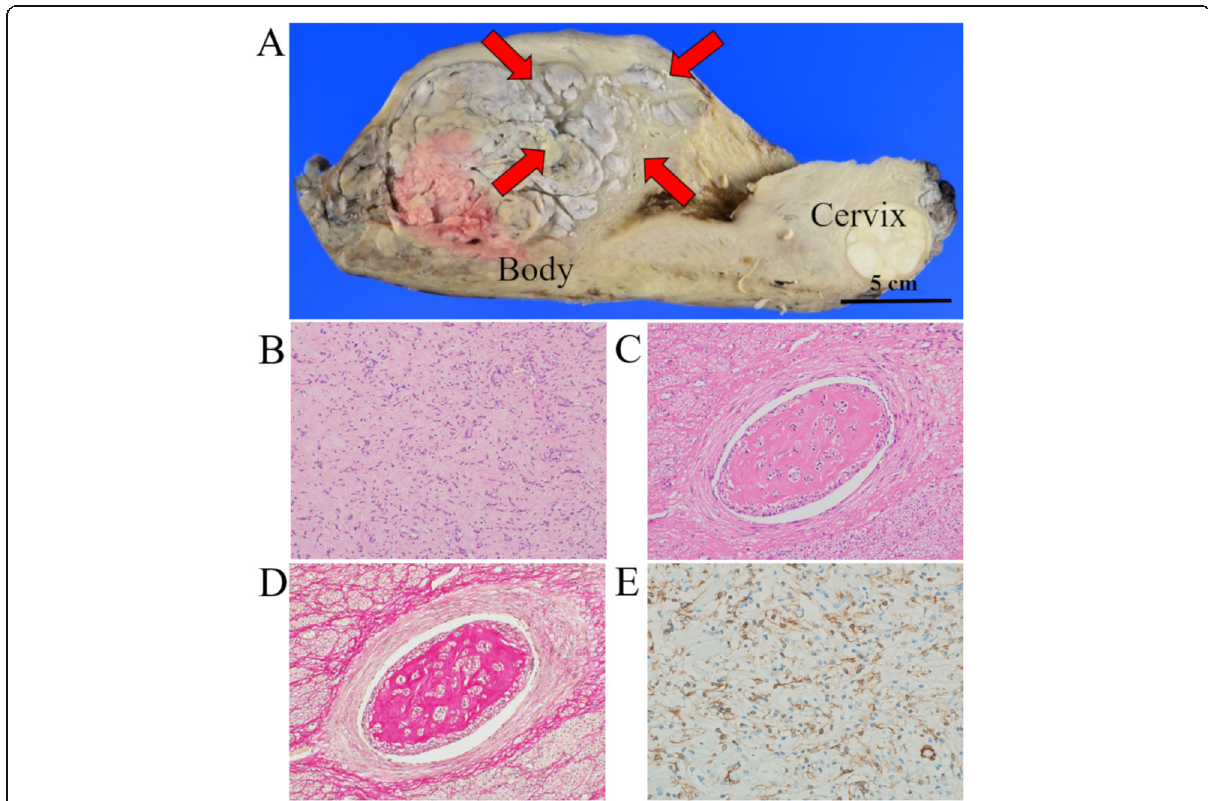
Fig. 3 The macroscopic and microscopic findings and immunohistochemical staining of the uterine mass: a Macroscopically, the cut surface presented as a gray-white colored mass, with a “ worm-like ” appearance (red arrows). b Microscopically, the uterine large myoma presented spindle-like smooth muscle cells without atypia and mitosis. c and d The tumor showed a growth of benign leiomyomatous tissues within vascular vessels (C, H&E; D, Elastica van Gieson). e Immunohistochemically, the tumor was positive for α -SMA Table 1 Cardiac metastasis of intravenous leiomyomatosis Case (year) Prognosis Present case (2018)